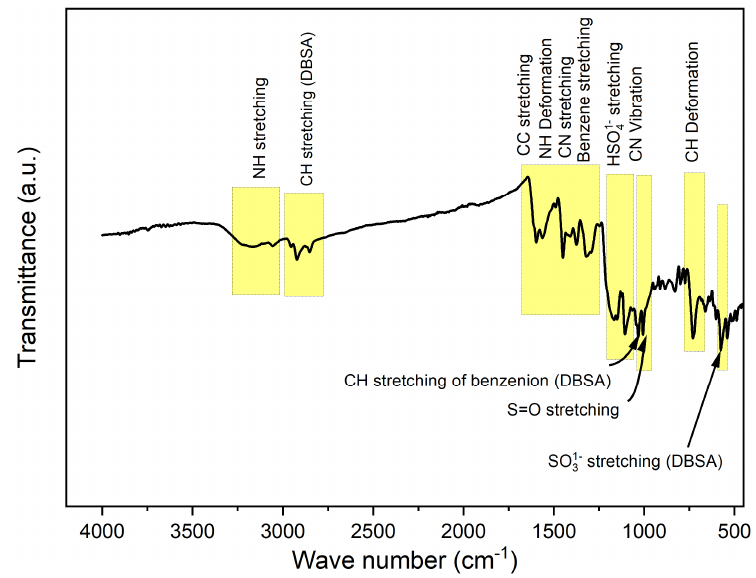
Figure 1. Representative FTIR spectrum of Pbp S ‐ 2.5A/B doped with H 2 SO 4 and DBSA.